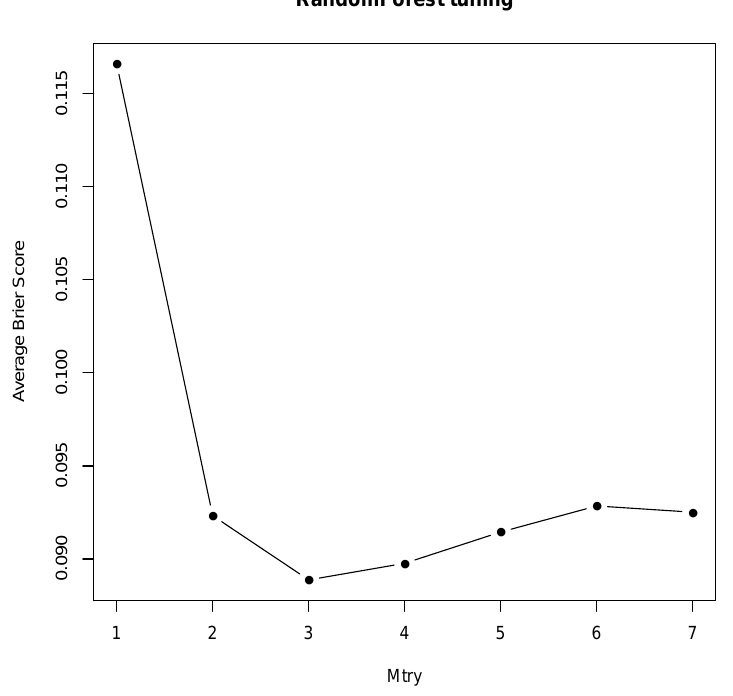
Figure 5. The performance profile of the random forest for predicting the statement mutation